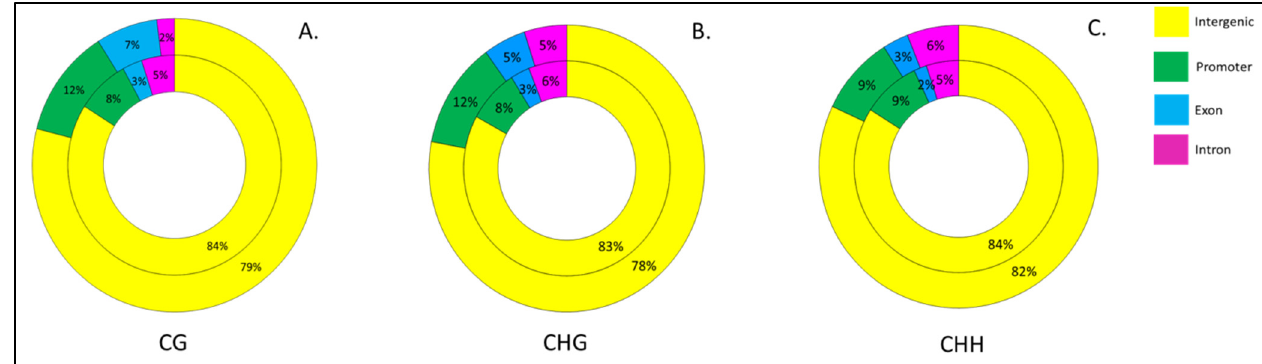
Figure 6. Percentage of Differentially Hypo- and Hypermethylated cytosines in promoters, exons, introns and intergenic regions in ( A ) CG ( B ) CHG and ( C ) CHH contexts. The inner circle represents phyllody (HF vs. I1) and outer circle represents little leaf affected sesame (H1 vs. LL). Generally, the methylation in the intergenic region was higher in little leaf (H1 vs.